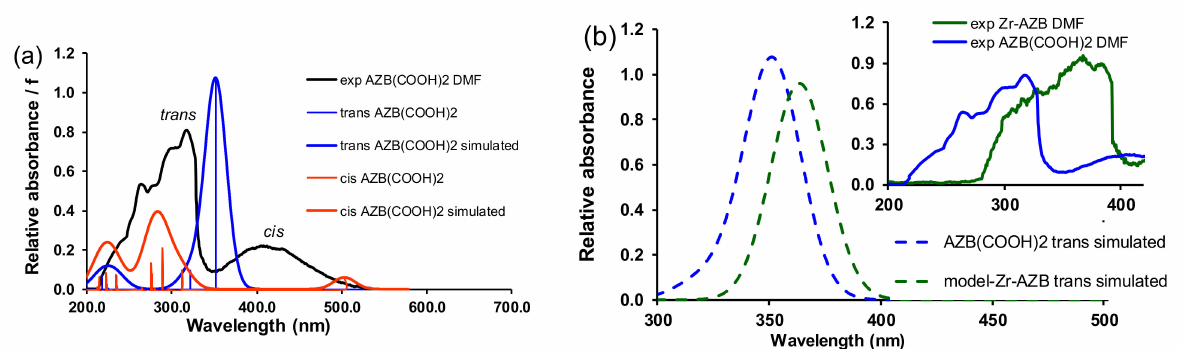
Figure 6. B3LYP gas phase TDDFT calculated oscillators and Gaussian broadening curves (30 nm halfwidth) of ( a ) trans (blue curve) and cis (red curve) AZB(COOH) 2 with the experimental spectrum in DMF shown in black, ( b ) trans (blue curve) AZB(COOH) 2 and trans model-Zr-AZB (green curve) with the corresponding experimental spectra in DMF shown in the inset in blue ( trans peak of AZB(COOH) 2 ) and green ( trans peak of